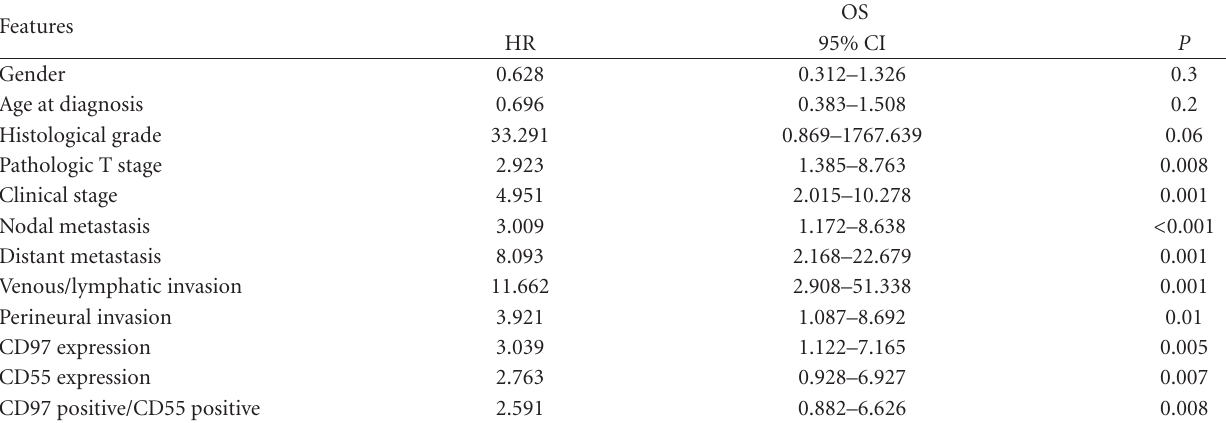
Table 2: Univariate analysis of the associations of prognosis with various clinicopathologic parameters in patients with